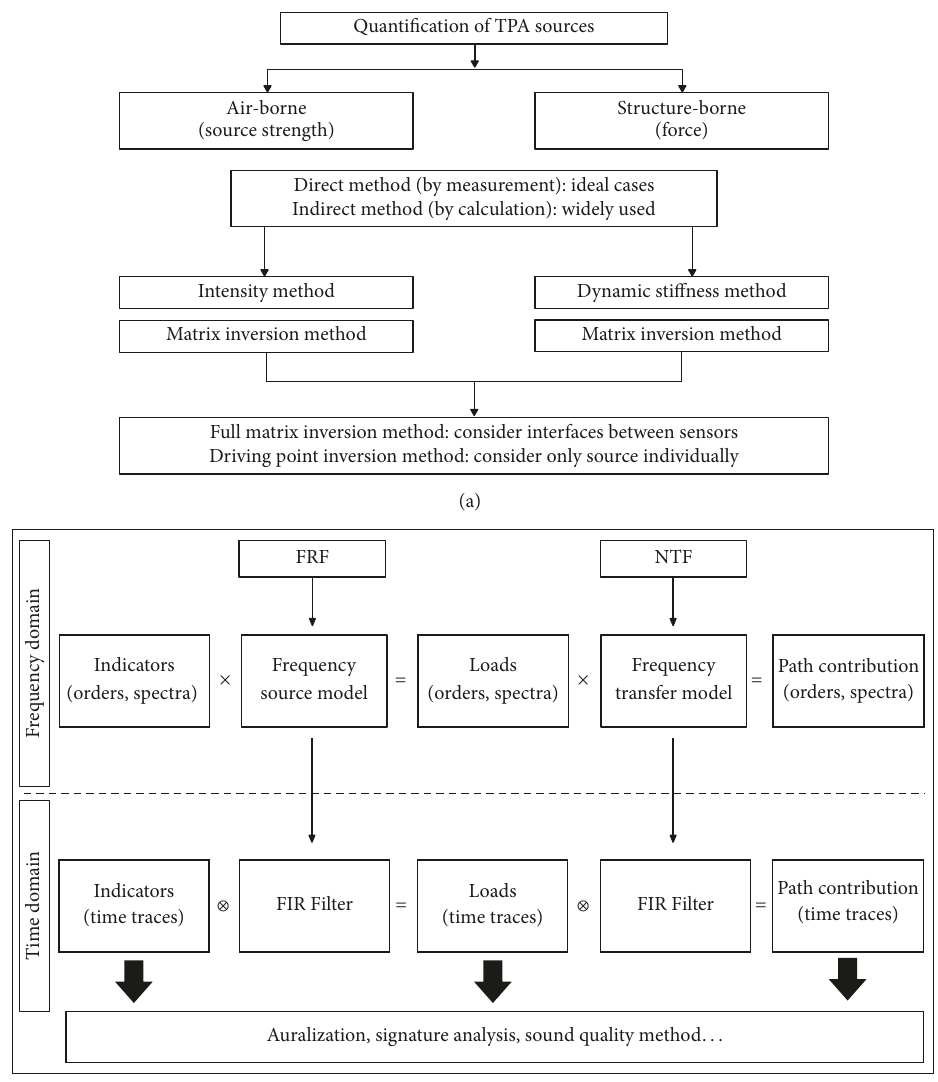
Figure 5: Transfer path analysis techniques: (a) process for quantifying TPA sources (Hwang et al. [23]), (b) signal processing for the time and frequency domains for TPA